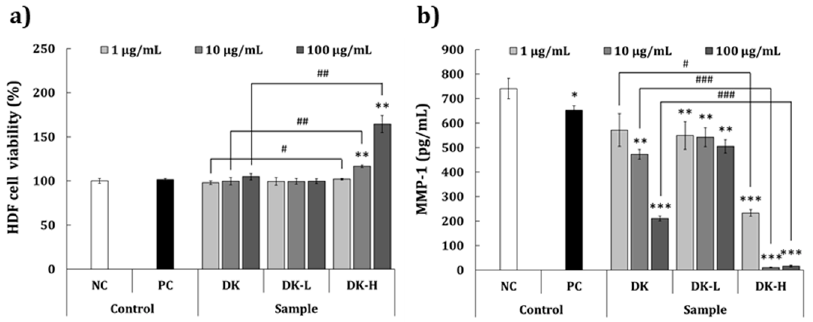
Figure 4. Effects of the fractions isolated from persimmon fruit on the ( a ) viability of human dermal fibroblasts (HDFa) and inhibition of ( b ) metalloproteinase-1 (MMP-1) in HDFa. Culture medium and retinoic acid (2 µ g/mL) were used as a negative control (NC) and positive control (PC), respectively. DK, DK-L, and DK-H refer to D. kaki extract and its low- and high-molecular-weight fractions, respectively. Statistical differences between the groups were analyzed by Student’s t -test. The asterisks indicate significant differences between each sample and LPS-treated control. The crosshatch patterns indicate significant differences between DK and DK-H at the same concentrations. * and #, p < 0.05; ** and ##, p < 0.01; *** and ###, p < 0.001.